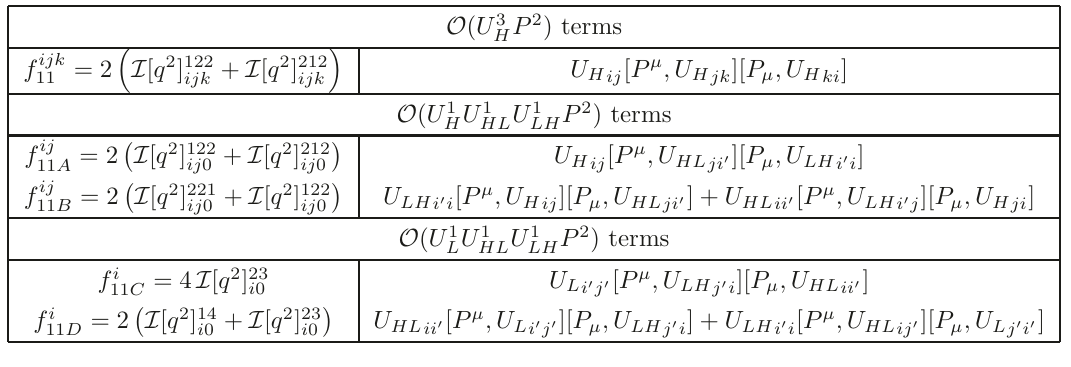
Table 2 . Universal coefficients f ijk